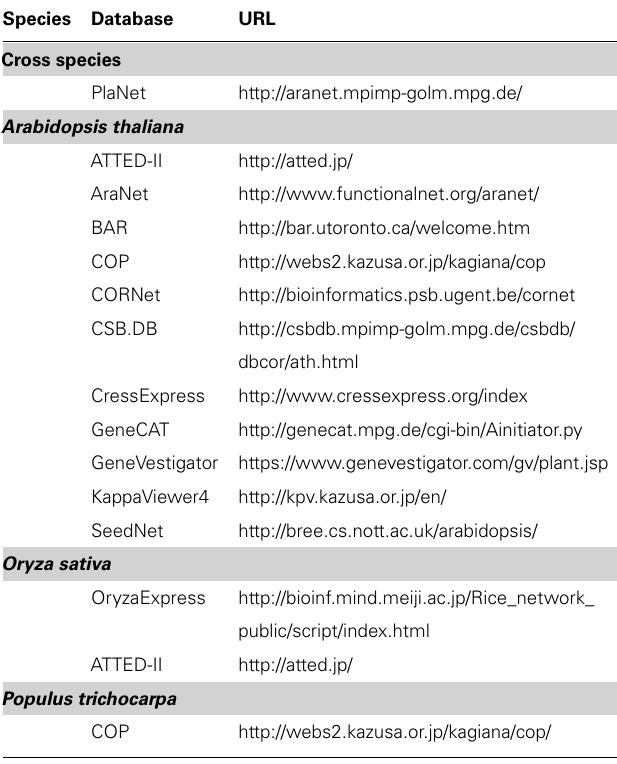
Table 1 | Co-expression databases presented in this